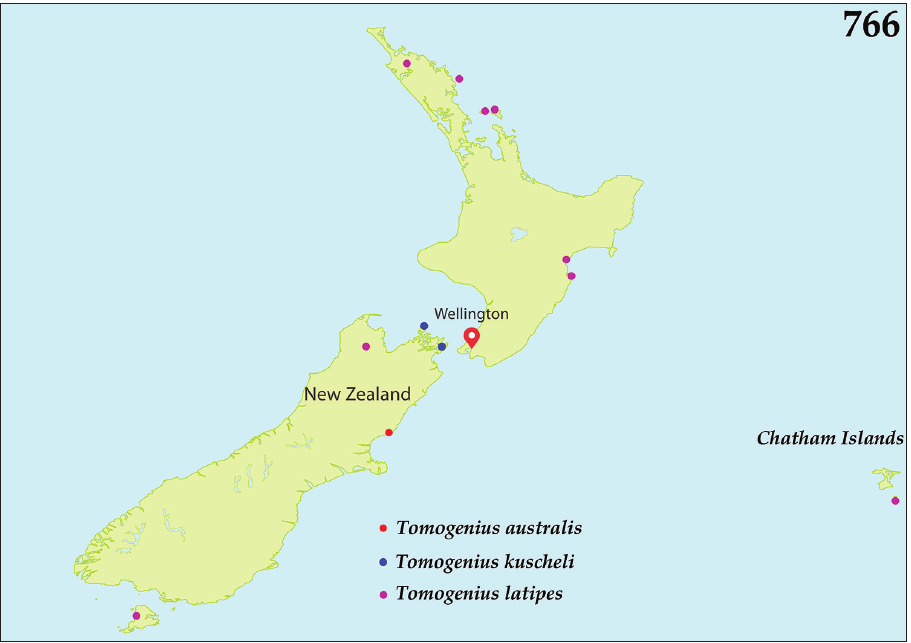
Figure 766. Distribution of the genus Tomogenius Marseul, 1862 in New Zeland: Tomogenius australis Dahlgren, 1976; Tomogenius kuscheli Dahlgren, 1976 and Tomogenius latipes (Broun,